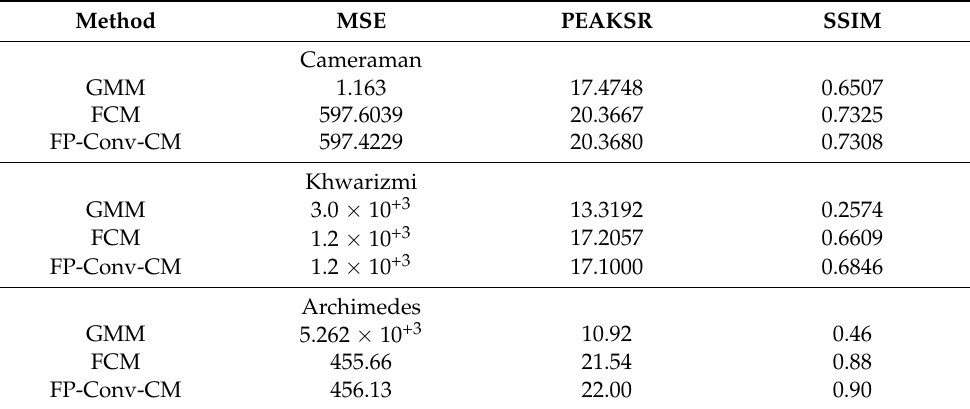
Table 4. MSE, PEAKSNR, and SSIM values associated with the images compressed by FCM, GMM, and